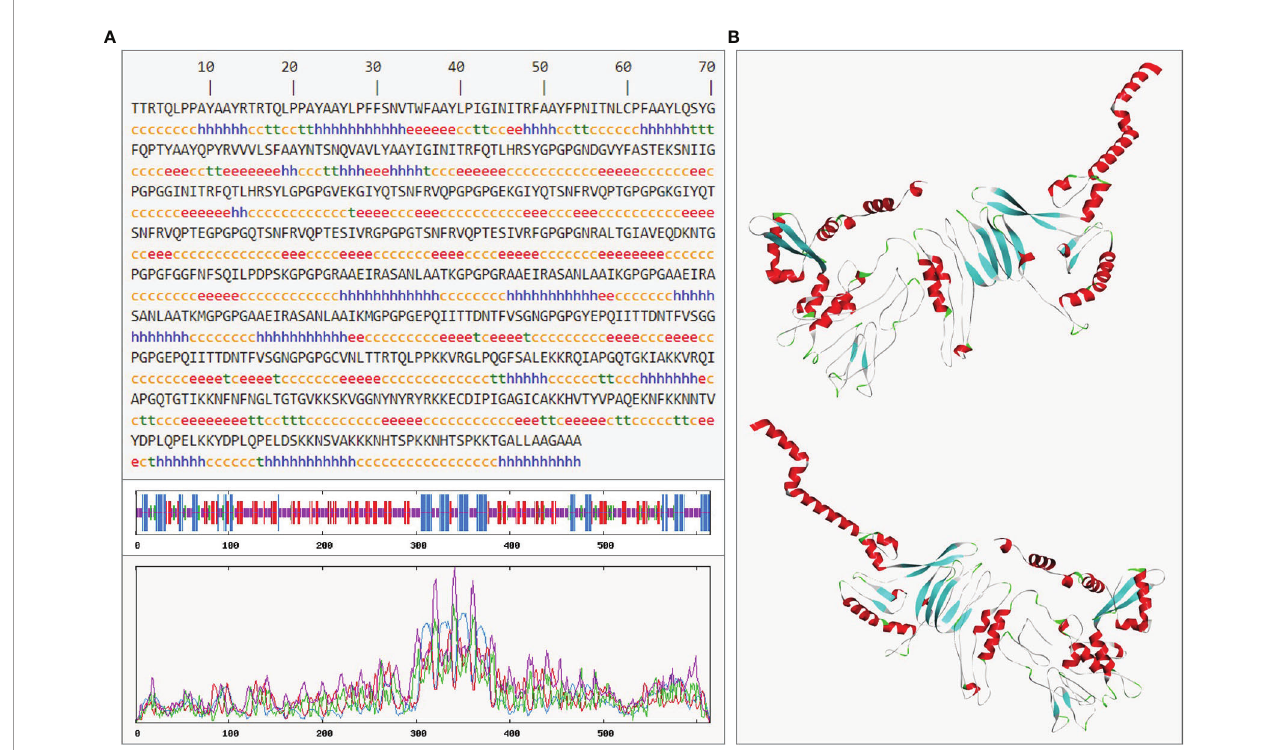
FIGURE 9 | The prediction of rSMEV secondary and tertiary structure. (A) In the prediction of rSMEV secondary structure, the “ h ” represented the Alpha helix, the “ e ” represented the Extended strand, the “ t ” represented the Beta turn and the “ c ” represented the Random coil. (B) In this 3D model, the tertiary structure was displayed in front view and back view. The “ red ” part was Alpha helix, the “ cyan ” part was Extended strand, the “ green ” pare was Beta turn and the “ gray ” part was Random coil in 3D